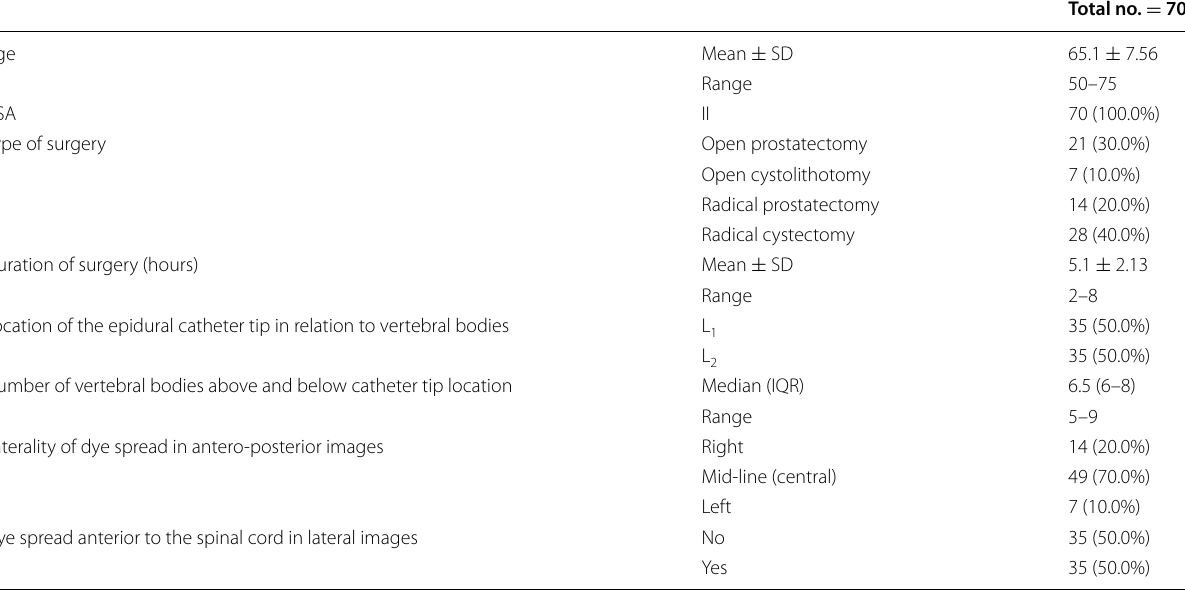
Table 1 Demographic and fluoroscopic characteristics of epidurals in the studied